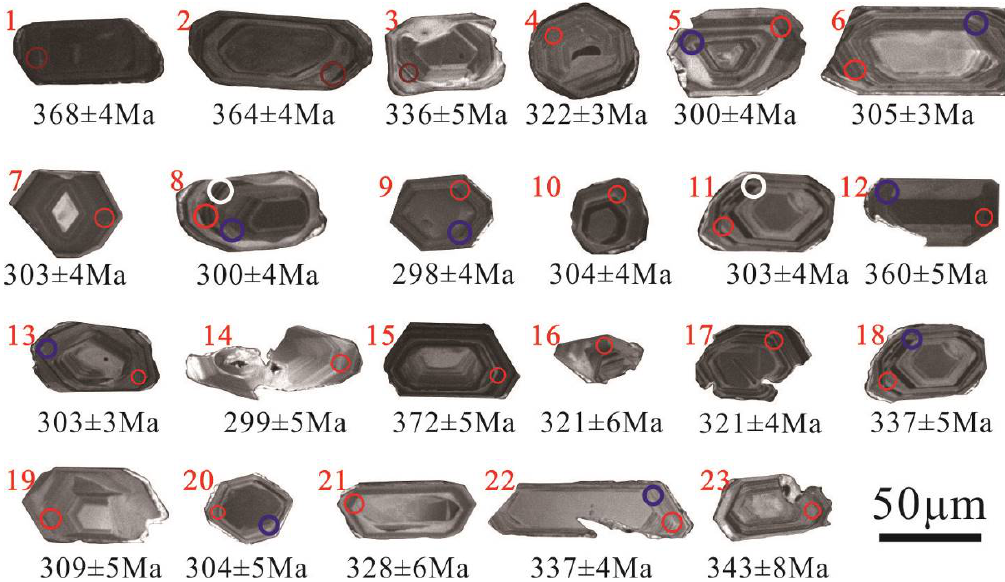
Figure 4. Cathodoluminescence (CL) images of zircon from Tonggou mineralization granodiorite (TMG), showing analytical spots and corresponding ages. Red circles represent analytical spots of U–Pb dating, blue circles represent analytical spots of Hf isotope, white represents analytical spots of trace elements.